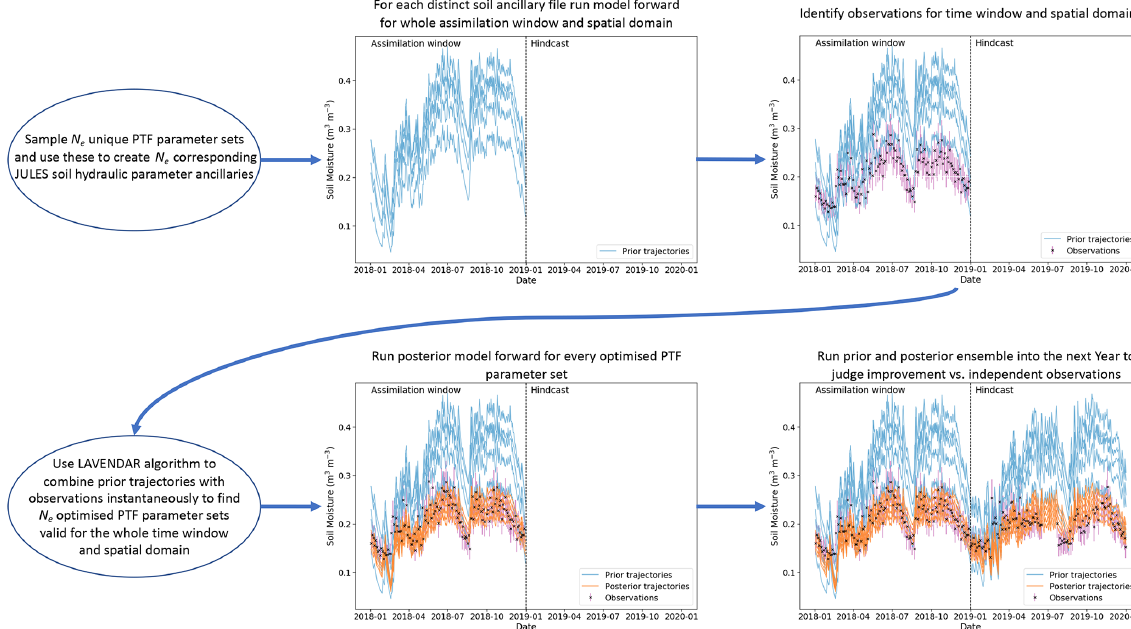
Figure 3. Schematic of the LAVENDAR data assimilation framework, showing the workflow for the experiment. Here N e is the chosen size of ensemble; in the schematic we show N e = 5, but in practice for our experiments N e = 50.